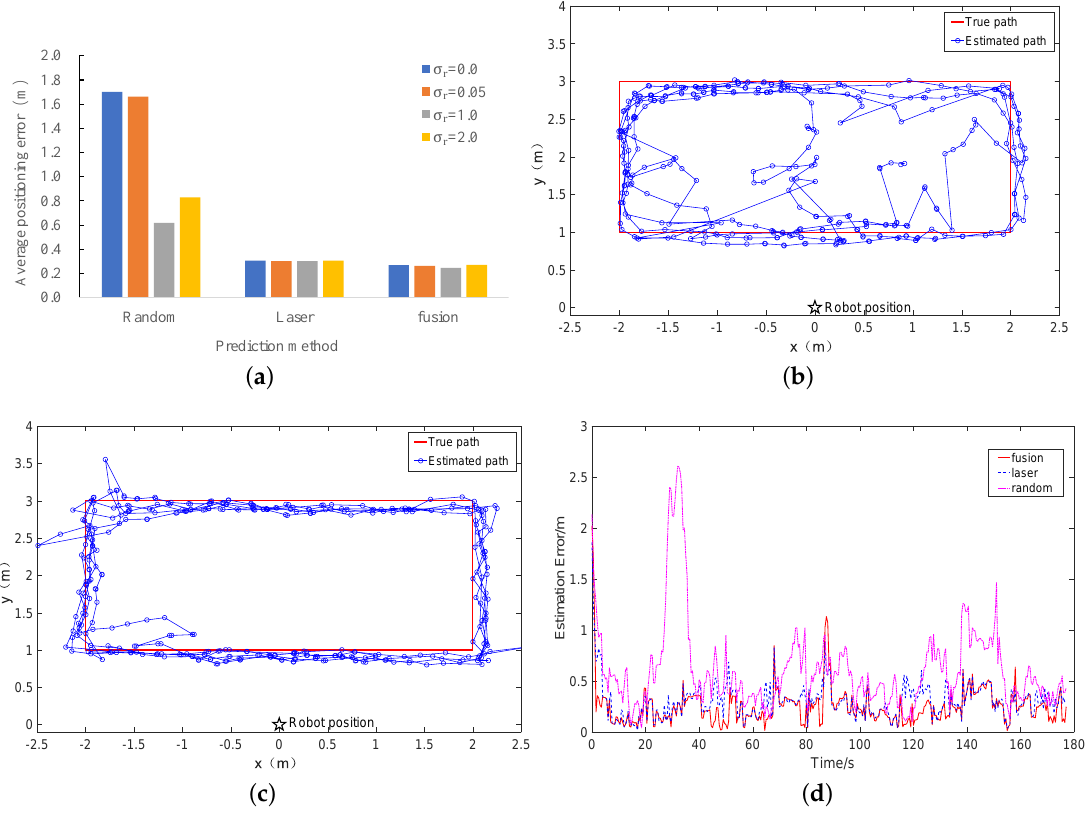
Figure 8. Comparison of the performance in three different prediction forms. ( a ) mean positioning accuracy under different prediction forms; ( b ) ground truth and estimated track of random prediction; ( c ) ground truth and estimated track of laser prediction; ( d ) estimation error at different